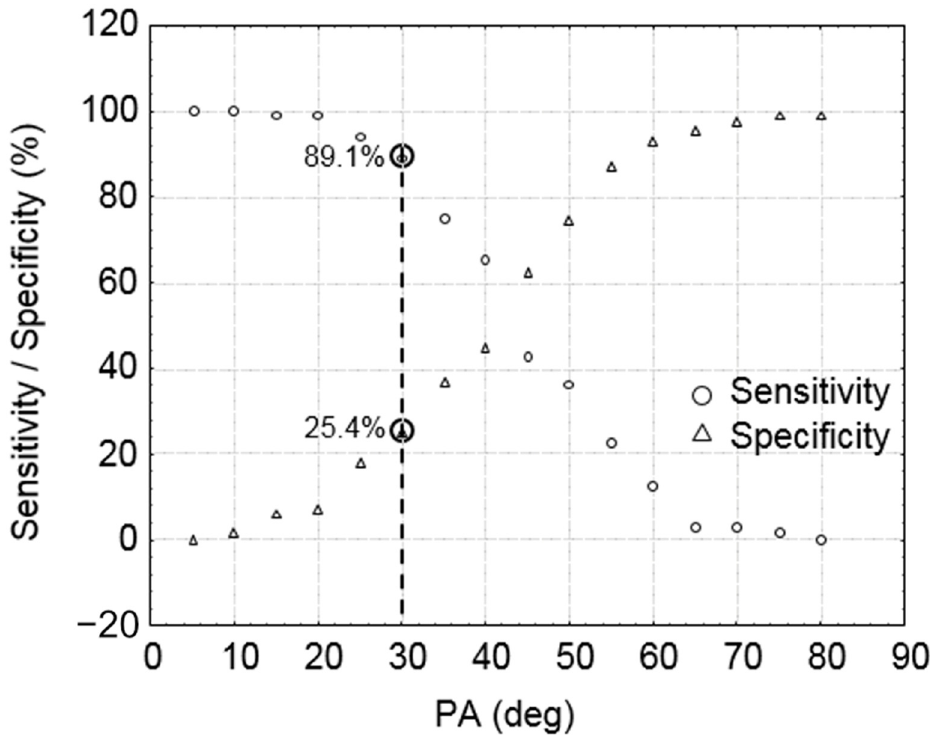
Figure 5. The results of ROC analysis (AUC = 0.587, p = 0.022) indicate that the value of popliteal angle (PA = 30°) generates the cutoff value (sensitivity = 89.07%, specificity = 25.44%) to detect the absence of knee flexors hypertonia. For PA ≥ 30°, the probability of absence of hypertonia decreases. ROC analysis suggested that K ts ≥ 13.93° (sensitivity = 75.0%) and PA ≥ 30° (sensitivity = 89.1%) were affected by the presence of